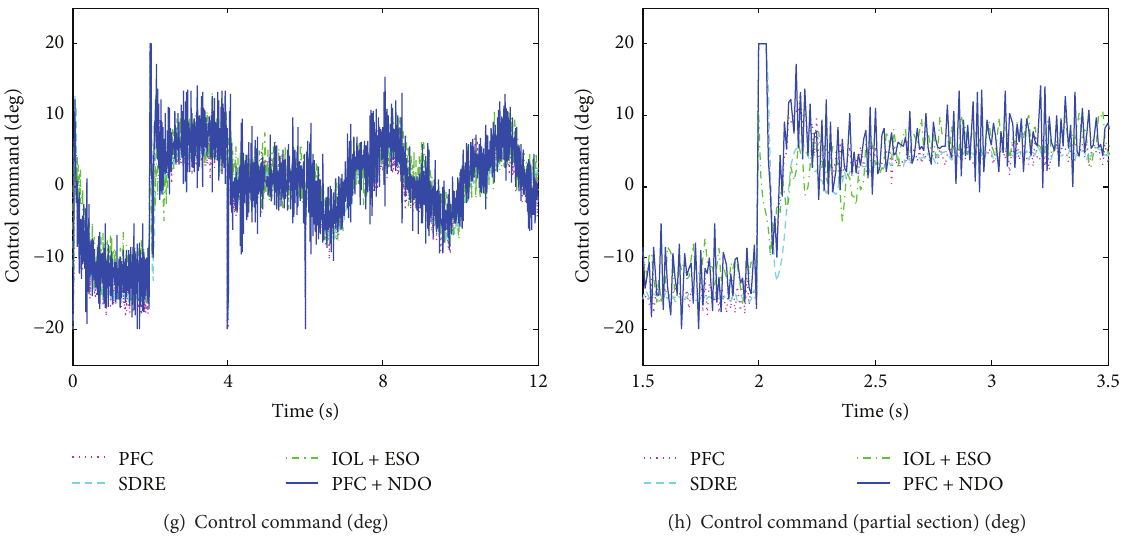
Figure 4: Simulation responses under the four controllers and the estimate performance of the NDO with measurement noise in the case of positive uncertainties and